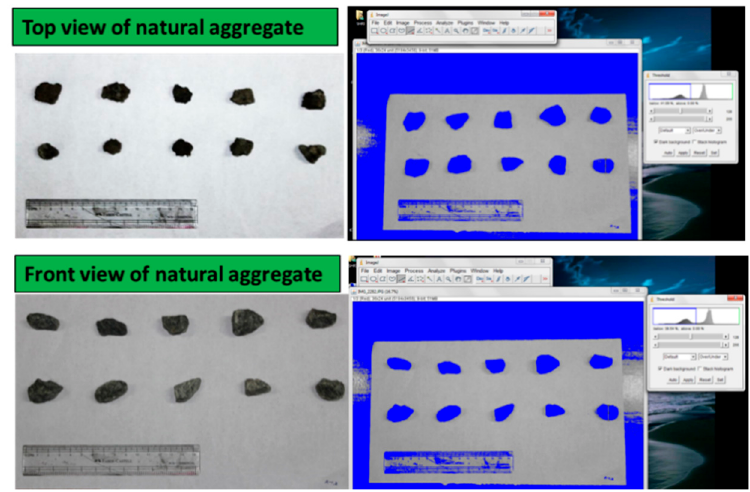
Figure 13. Top and front view of natural aggregate and thresholded images.